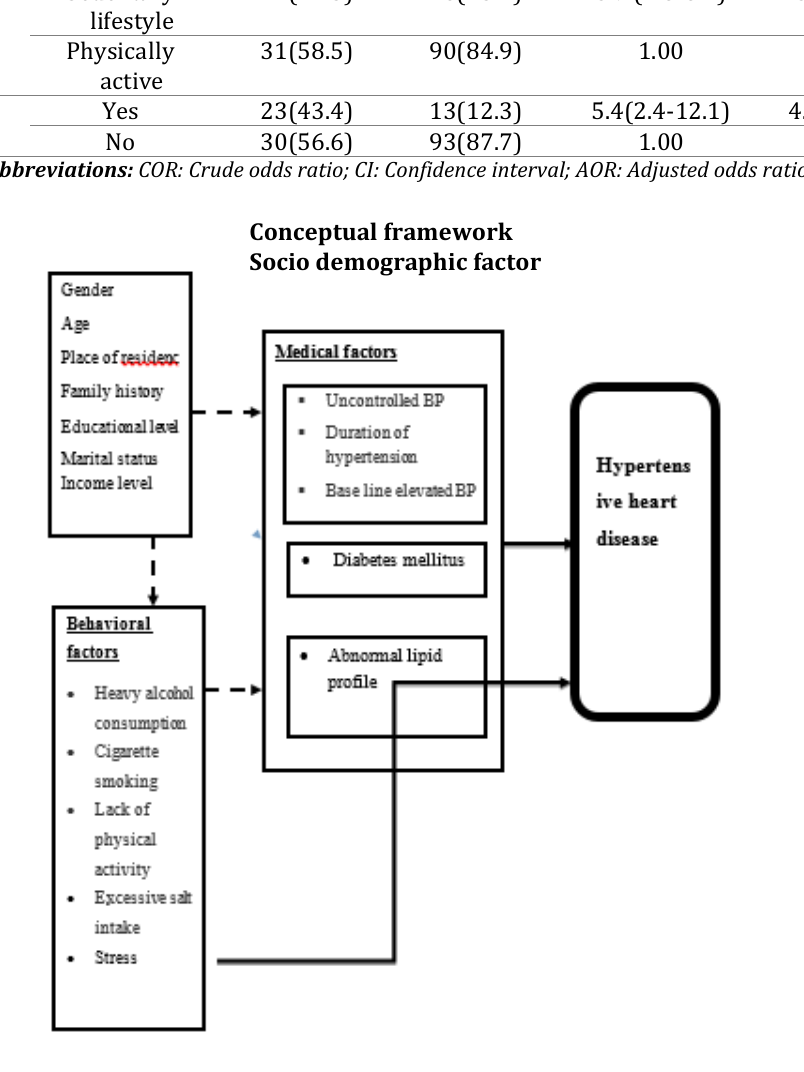
Figure 1: Conceptual frame work for studying determinants of hypertensive heart disease among adult hypertensive patients in university of Gondar referral hospital, Gondar North West Ethiopia, a